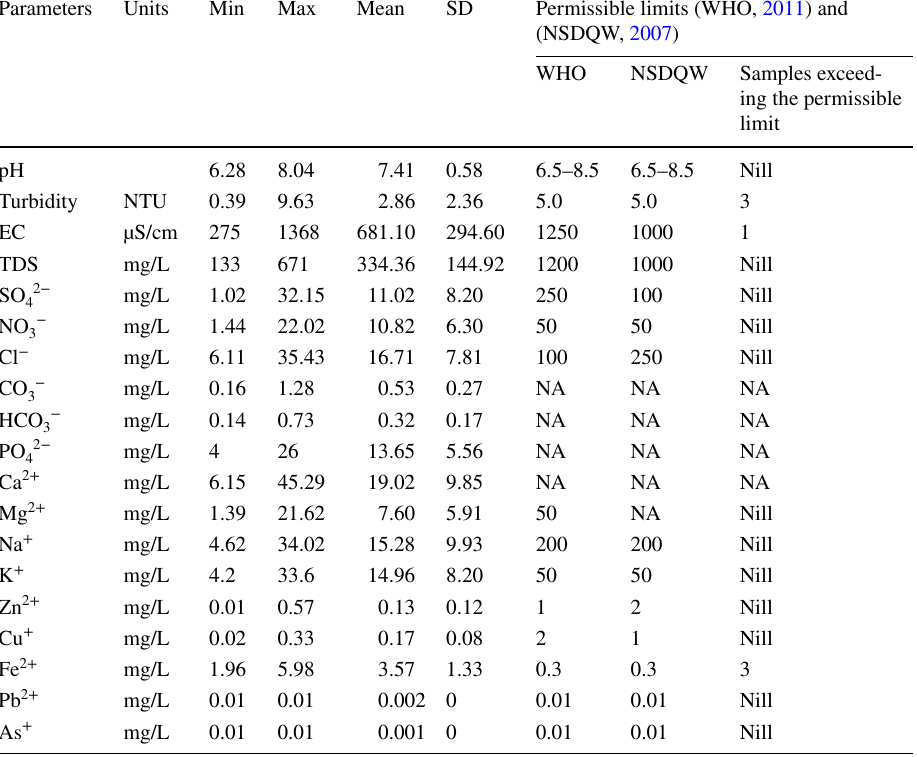
Table 2 Summary statistics of Physico-chemical quality parameters of groundwater samples